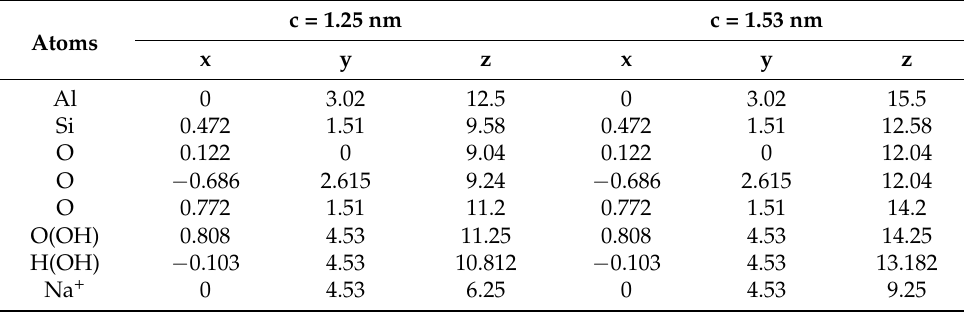
ε denotes the dielectric constant, 8.854 × 10 − 12 0